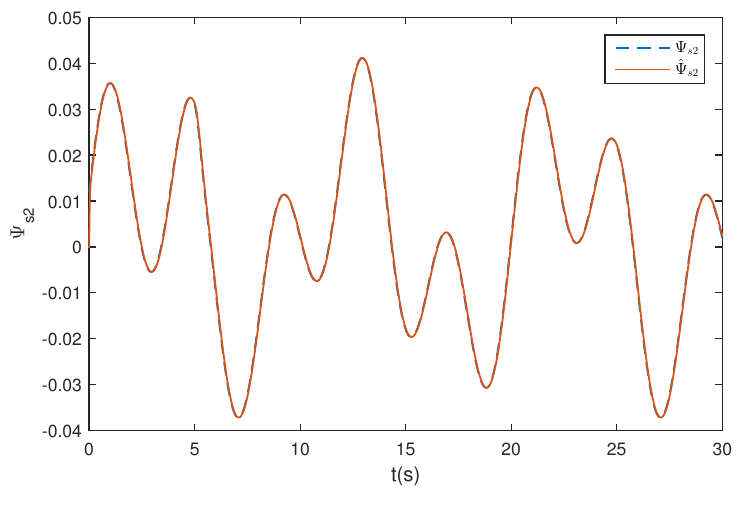
Figure 24. Estimation of Ψ s 2 under NBD.